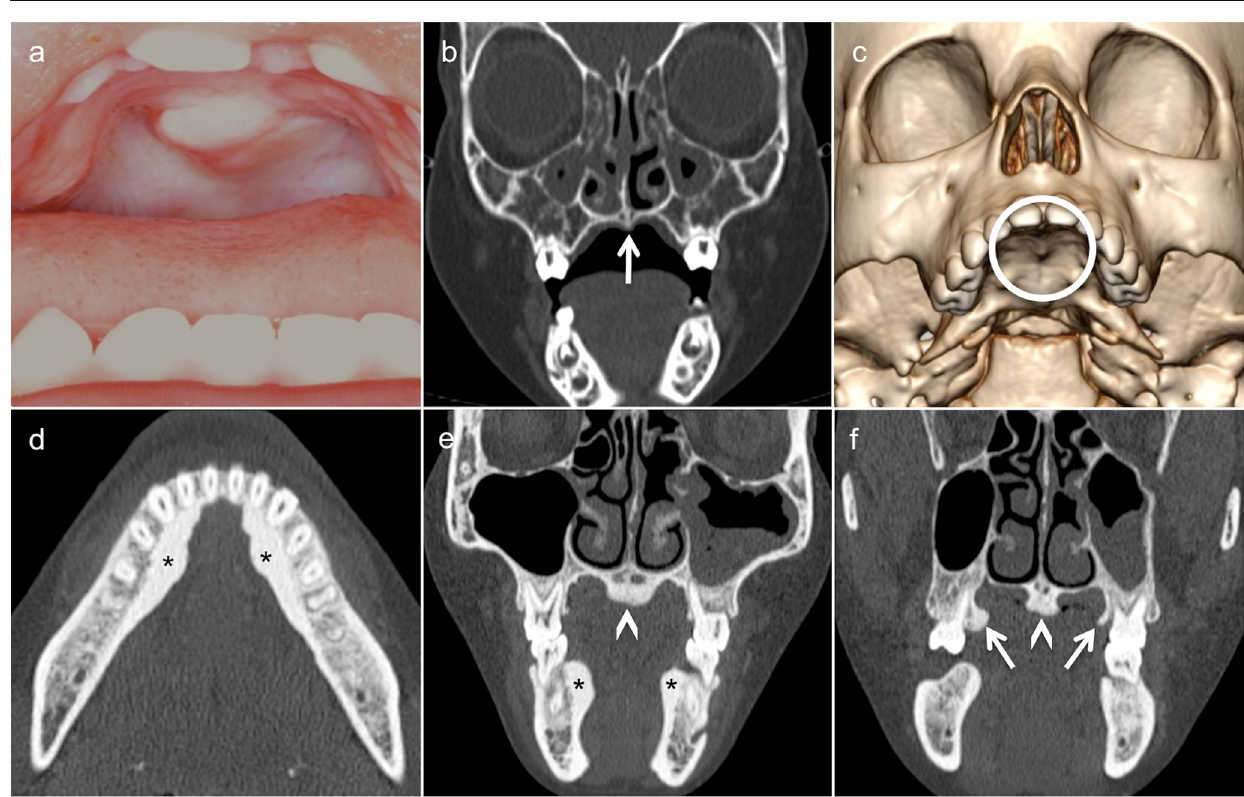
Fig. 6 Torus palatinus (TP) in a 3-year-old girl who underwent imaging because of an indurated palpable midline mass of the hard palate increas- ing in size ( a ) after a fall occurring from a swing hanging on a tree two weeks earlier. Coronal low-dose CT image (bone window) ( b ) and three- dimensional CT VR reconstruction show a small midline spur/exostosis